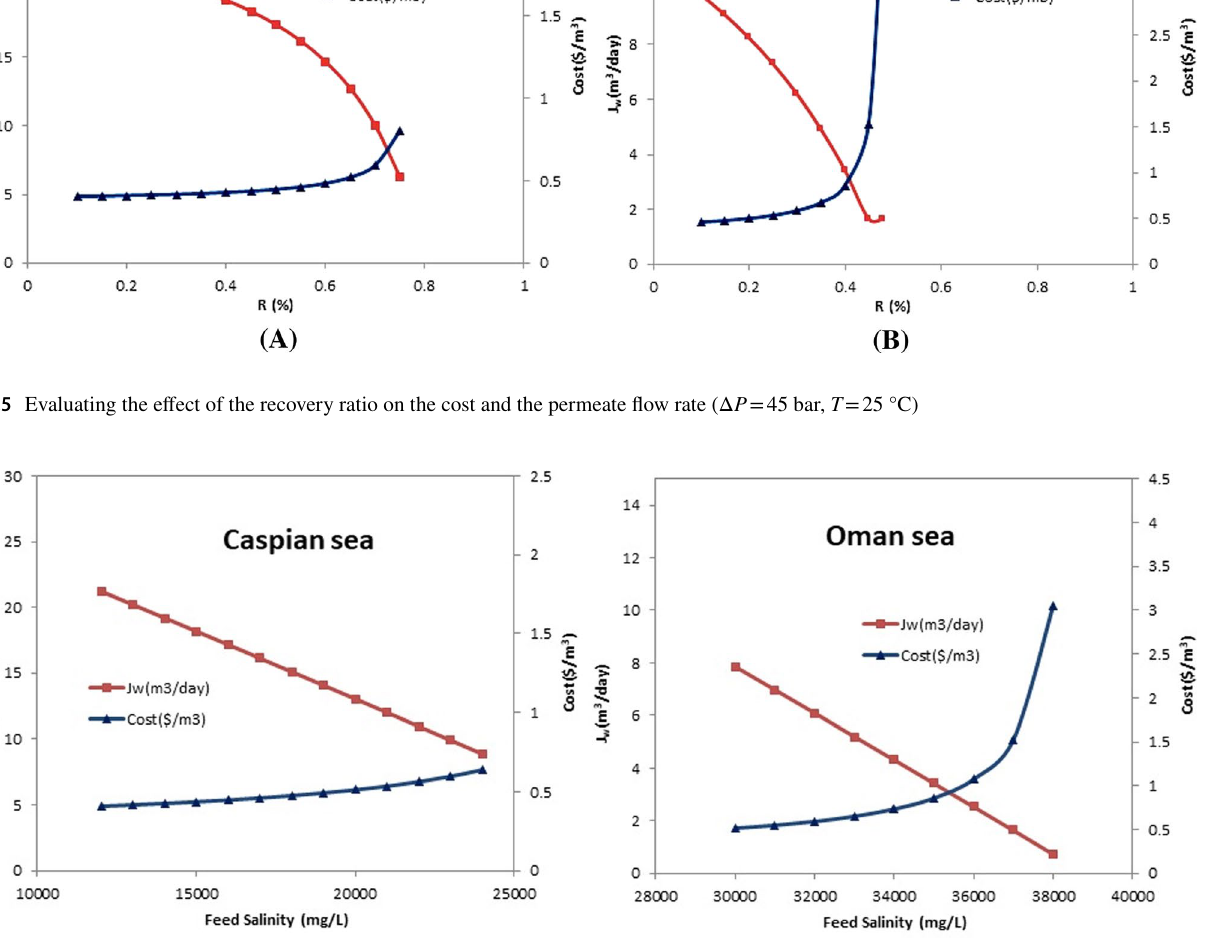
R Caspian = 0.55, Oman =